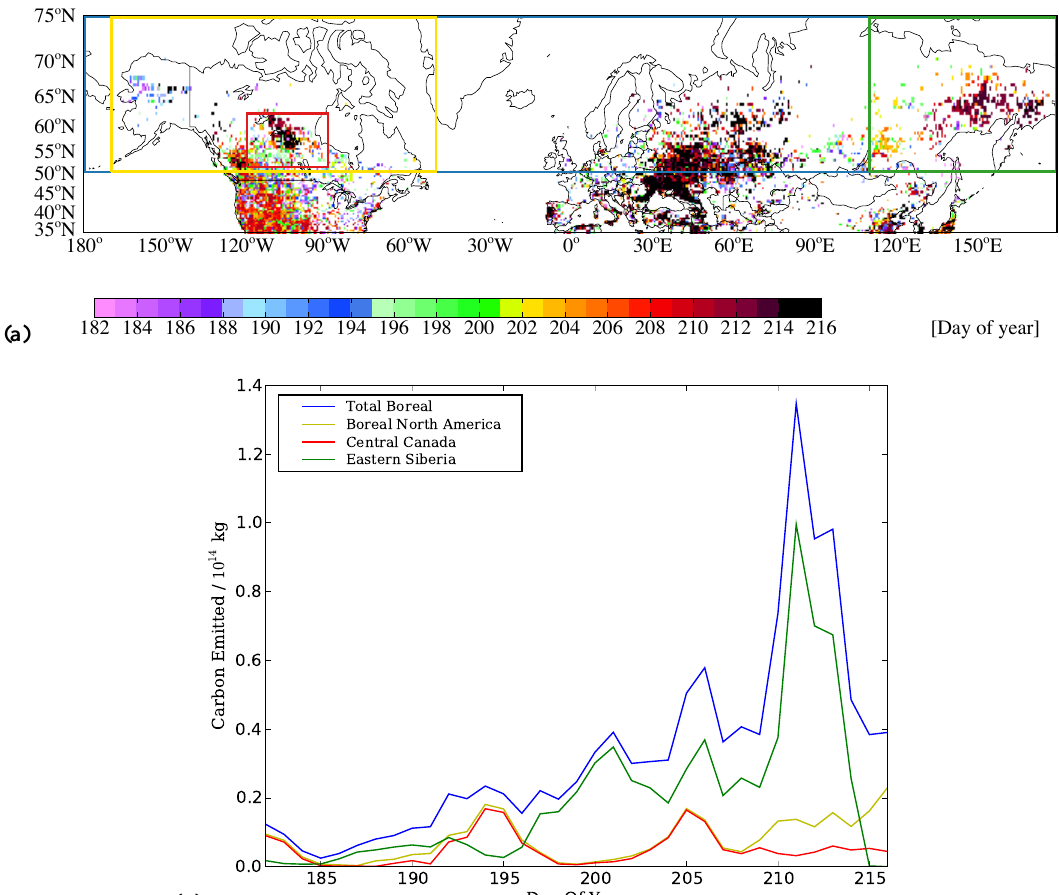
Fig. 1. Daily distribution of GOES and MODIS active fire used in the FLAMBE inventory and the estimated total carbon emissions, in kg, from 1 July (day 182) and 4 August (day 216) 2010. Plot (a) shows the distribution of fire hotspots across the northern extra-tropics as a function of day of year. Plot (b) shows timeseries of the daily total carbon emitted for the boreal region (latitudes > 50 ◦ N), boreal North America (170 ◦ –50 ◦ W, 50 ◦ –75 ◦ N), Central Canada (120 ◦ –90 ◦ W, 52 ◦ –62 ◦ N), and Eastern Siberia (110 ◦ –180 ◦ E, 50 ◦ –75 ◦ N). Line colours in plot (b) correspond to the boxes shown in plot (a) in which total emissions for each region are